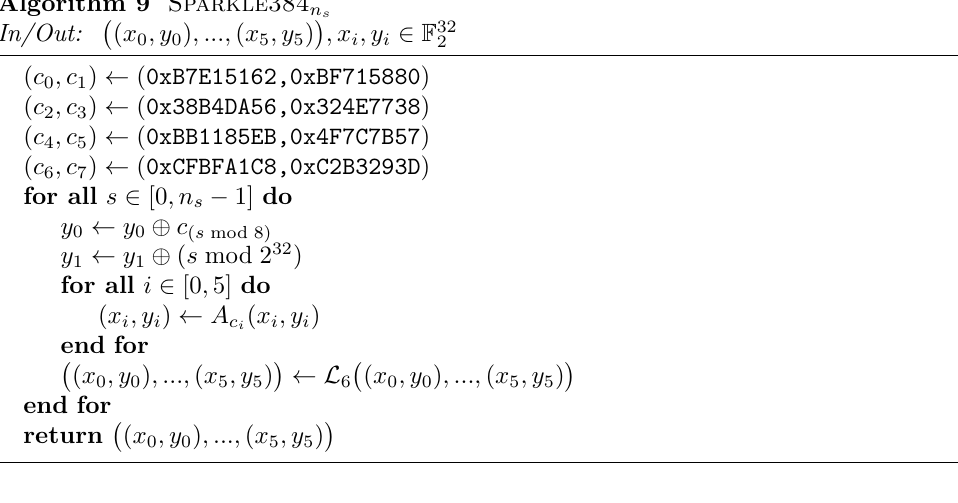
Algorithm 10 Sparkle512 𝑛